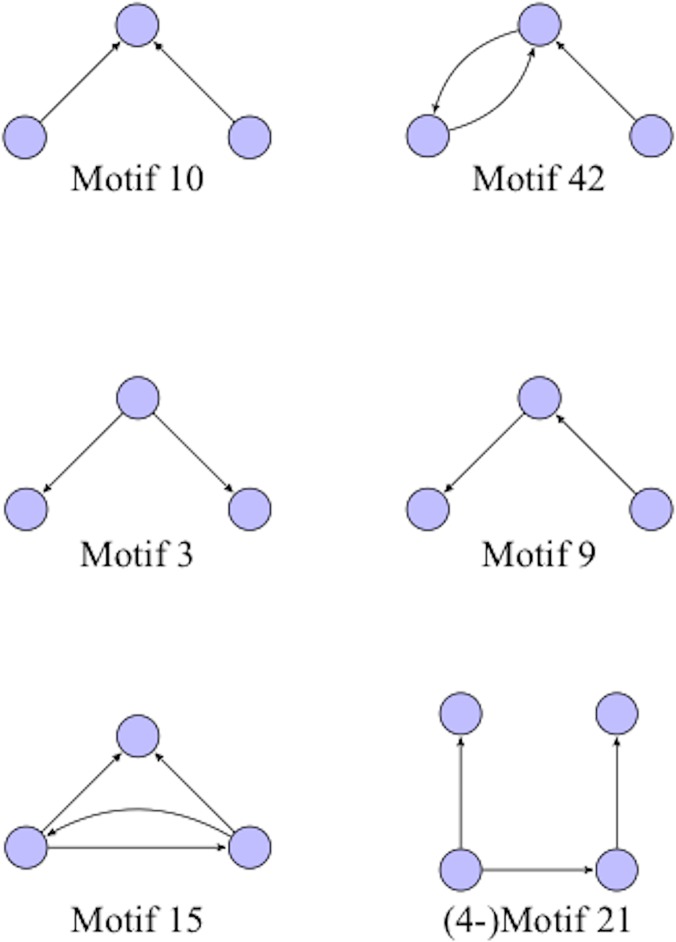
Representative motifs.Representative 3-node motifs (and one 4-node directed motifs). The motif ID numbers are those used by the Kavosh software (Kashani et al. 2009). Note that the motif ID numbers for different values of k can be duplicates, i.e. the same motif number can refer to both a 2-motif and a 3-motif.